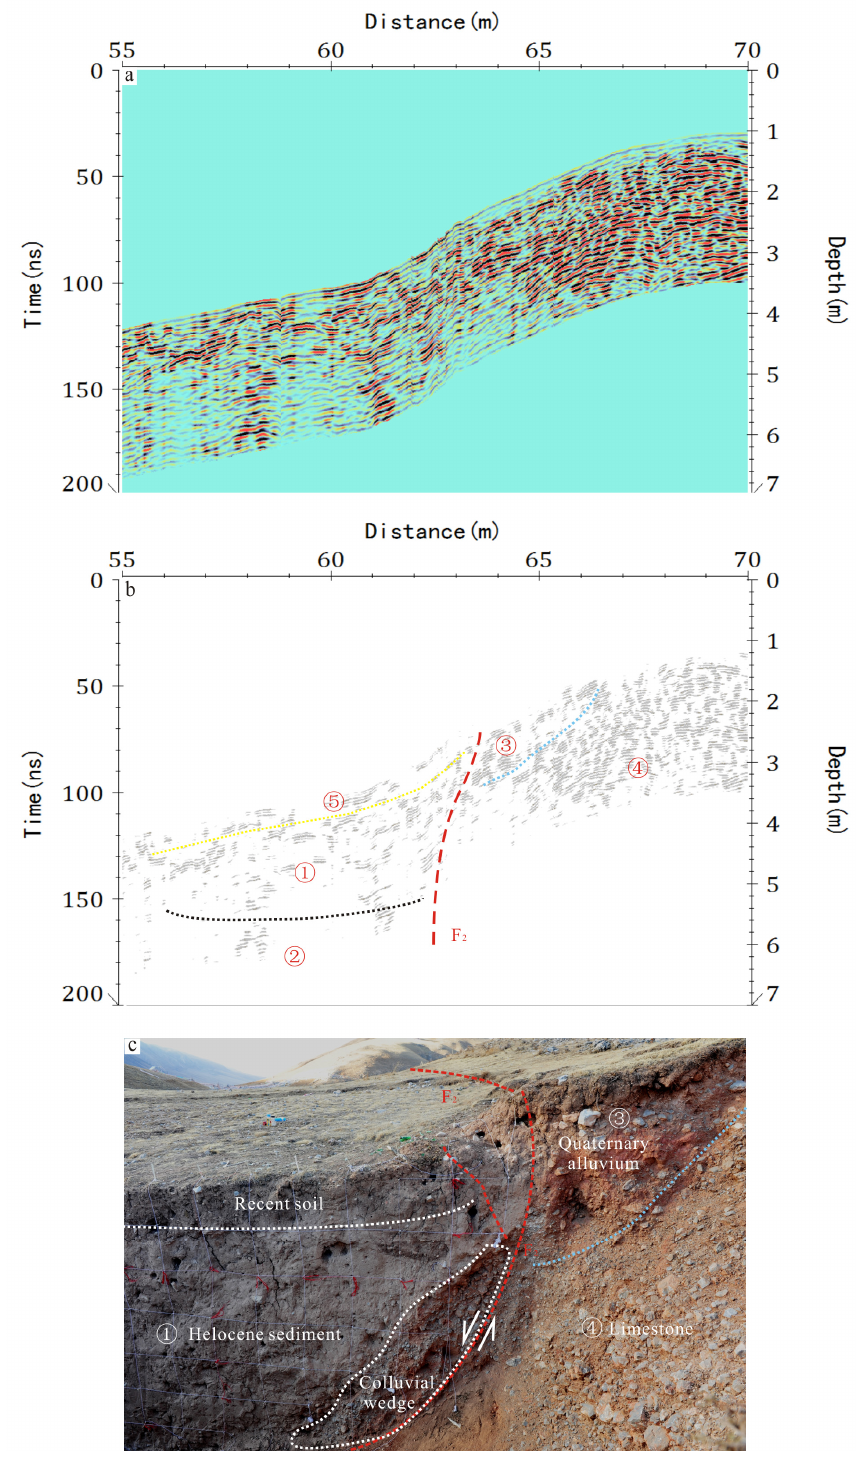
Figure 10. 500 MHz GPR image and trench section. ( a ) The processed 500 MHz GPR data (distances of ~55 m to 70 m in Figure 9c). ( b ) The interpreted 500 MHz GPR data. Yellow, black and blue dotted lines indicate interfaces of the stratigraphic units, and five stratigraphic units were identified on 500 MHz GPR data. The red dotted line is the fault, F 2 . ( c ) Detailed logging of the trench (the western section). Four stratigraphic units were distinguished on the trench section: recent soil, Holocene sediment, Quaternary alluvium and limestone. The white dotted irregular polygon is considered to be the colluvial